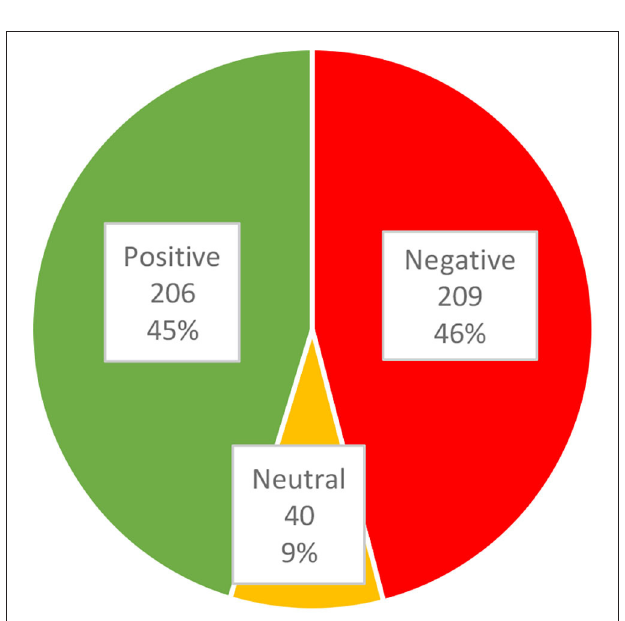
FIGURE 2 | Categories of caregivers’ attitudes ( n =